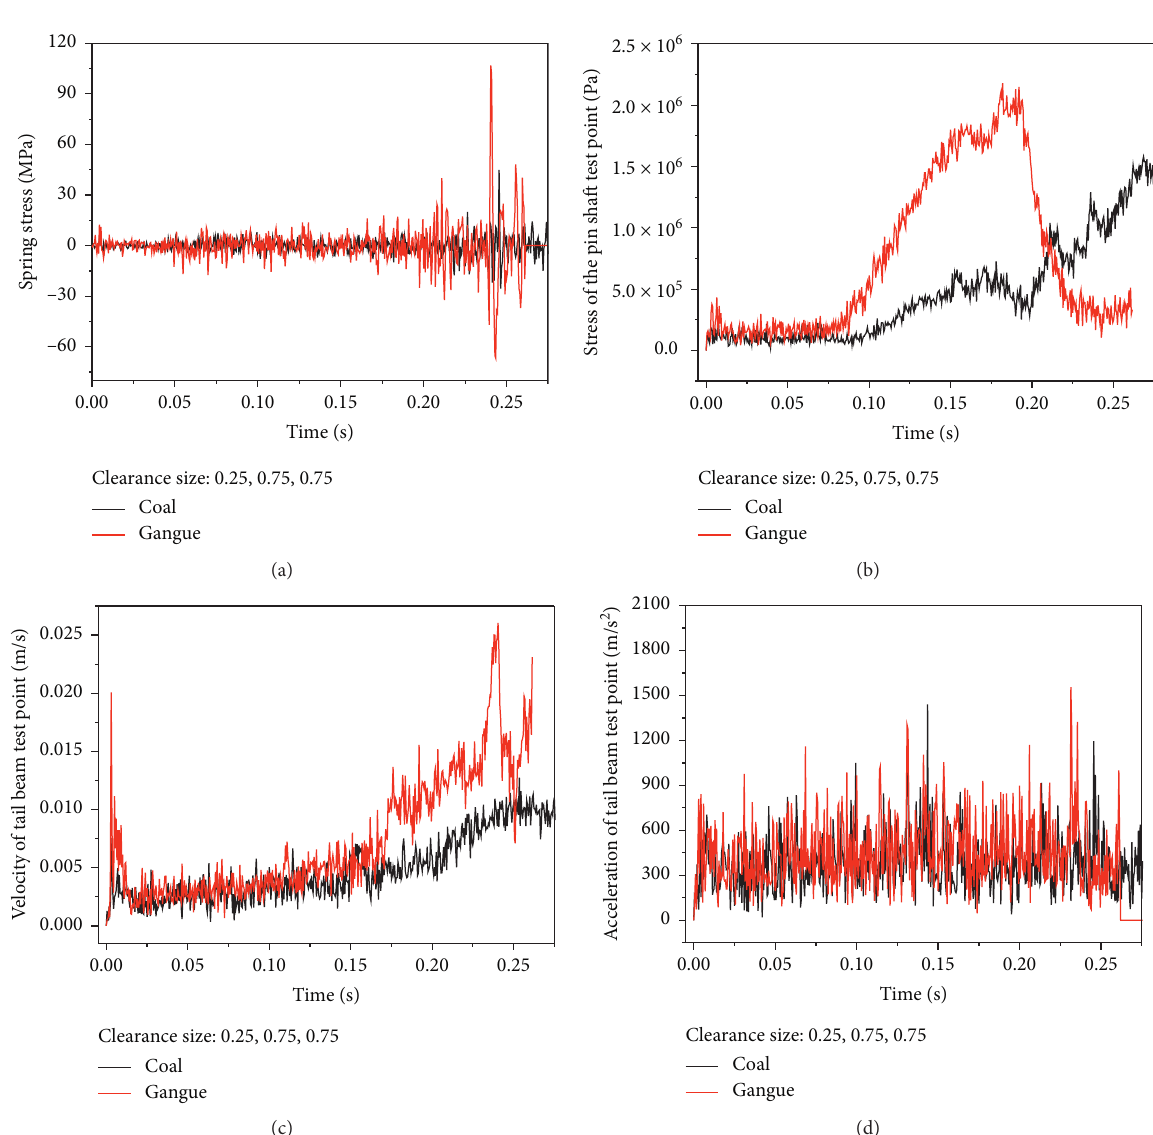
Figure 13: Impact contact response difference of the 3-clearance system. (a) Spring stress. (b) Stress of the pin shaft test point. (c) Velocity of the tail beam test point. (d) Acceleration of the tail beam test